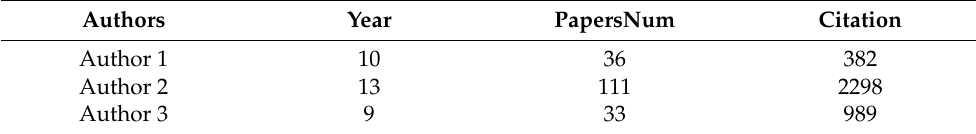
Figure 15. Similarity between authors based on keywords. Table 5. Authors’ statistics in relation to publication records.